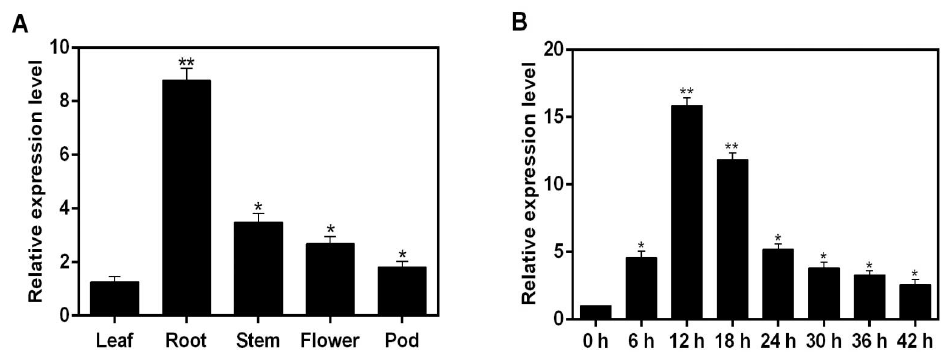
Figure 7. Expressions of GmNAC3 gene in different organs of soybean relative to that of leaf ( A ) and in roots of soybean seedlings treated with 20% PEG6000 for 42 h relative to 0 h ( B ) based on the real-time fluorescence quantitative real-time PCR. Symbols “*” and “**” indicate significant differences at p values of 0.05 and 0.01, respectively.